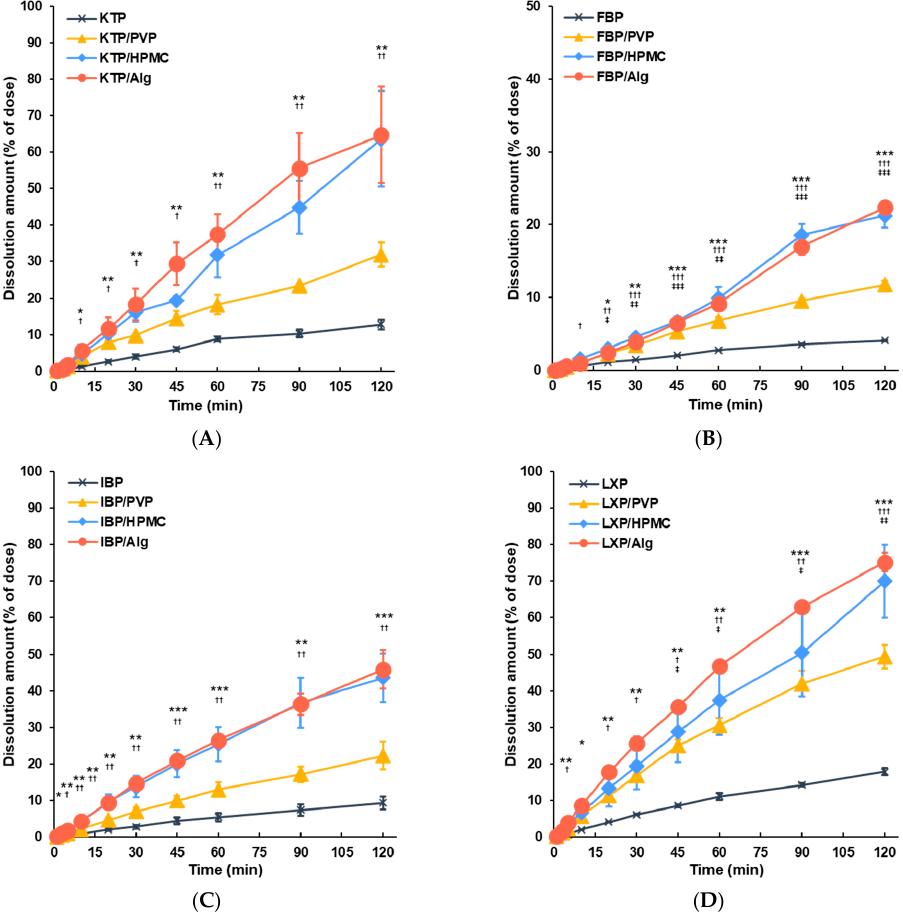
Figure 5. Dissolution profiles of film formulations for ( A ) KTP, ( B ) FBP, ( C ) IBP, and ( D ) LXP. Time profiles are shown for the control solid formulation derived from API alone (black), film formulation of API with PVP (yellow), film formulation of API with HPMC (blue), and film formulation of API with Alg (orange). Data are expressed as the mean ± SEM ( n = 3–5). Statistical significances are represented as triple, double, and single symbols for p < 0.001, p < 0.01, and p < 0.05, respectively, compared with each condition; *, API/Alg vs. API; †, API/HPMC vs. API; ‡, API/PVP vs. API. The dissolved amount per unit time (i.e., the average rate of dissolution) was calcu- lated from the increase between two adjacent sampling points ( k dis ). The dissolution rate ( k dis ) was found to increase for 10–15 min after film application, and remained constant until approximately 60 min, and then gradually decreased from 60 to 120 min (Figure S2 in Supplementary Materials). Therefore, two different average values of k dis were